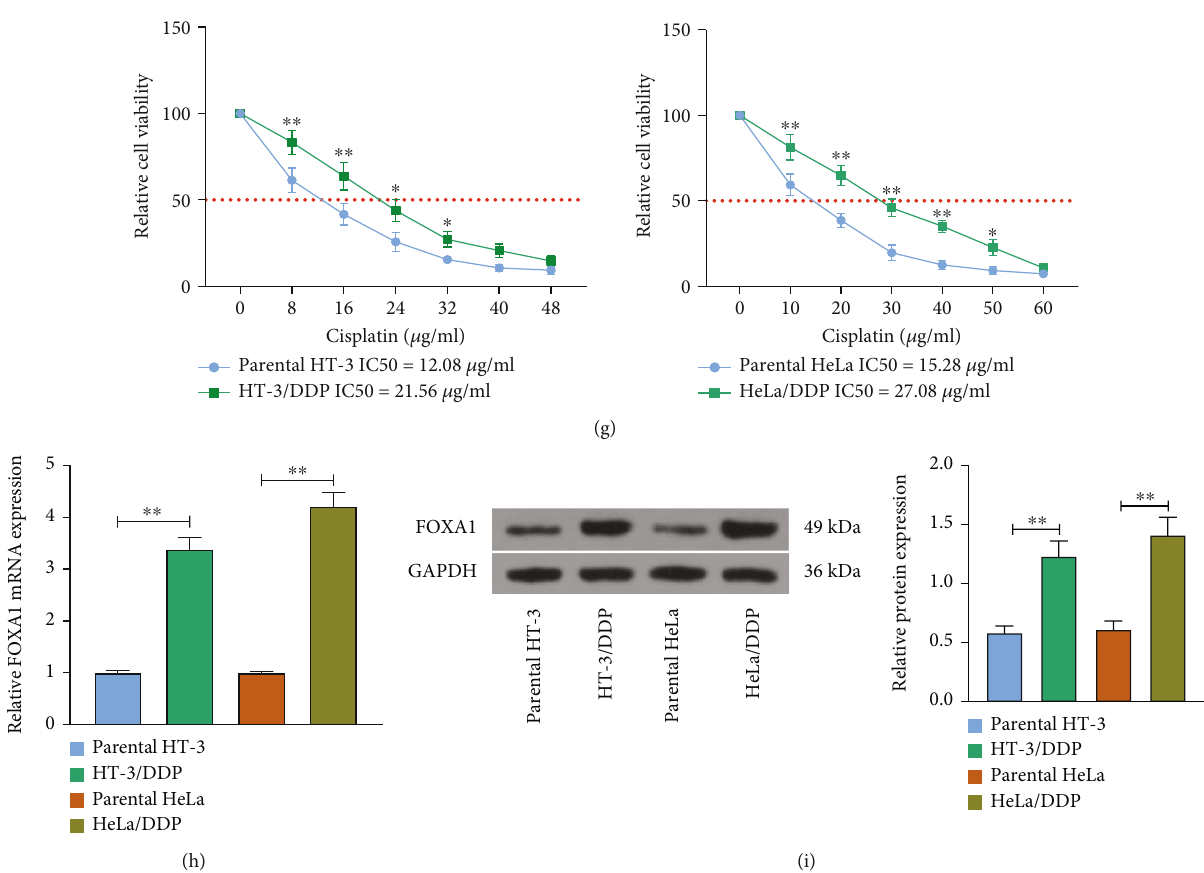
Figure 1: FOXA1 is highly expressed in CC and is associated with drug resistance. (a) GEO database analysis of di ff erentially expressed transcription factors in GSE64217 and GSE63514 datasets and Venn map plotting. (b) Expression of FOXA1 in multiple cancers in the GEPIA database. (c) FOXA1 is highly expressed in TCGA-CESC database. (d) High expression of FOXA1 in CESC in TCGA database. (e, f) FOXA1 expression in normal cervical epithelial cells H8 and CC cell lines (HT-3, CaSki, HeLa, and SiHa) at mRNA and protein levels by (e) RT-qPCR and (f) Western blot. (g) The IC50 value of cells to DDP by MTT assay to con fi rm the successful establishment of drug-resistant cell lines. (h, i) Detection of FOXA1 expression in parental cells and drug-resistant cells by (h) RT-qPCR and (i) Western blot. Data among multiple groups were analyzed by one-way or two-way ANOVA followed by Tukey ’ s post hoc test ( ∗ p < 0 : 05 ; ∗∗ p < 0 : 01 ). The cell experiment was independently repeated three